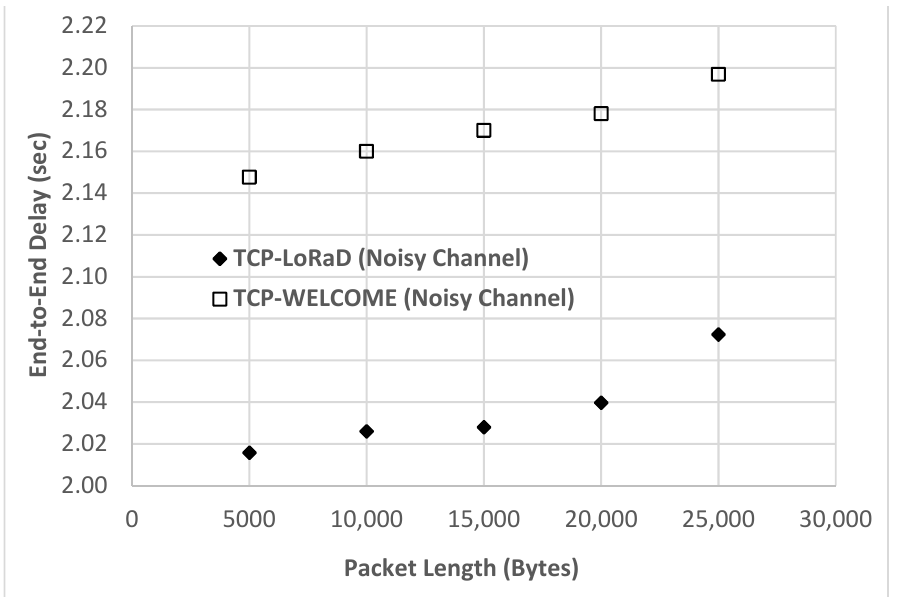
Figure 13. Throughput versus varying Packet Length in a noisy channel. Comparison of TCP-LoRaD and TCP-WELCOME.